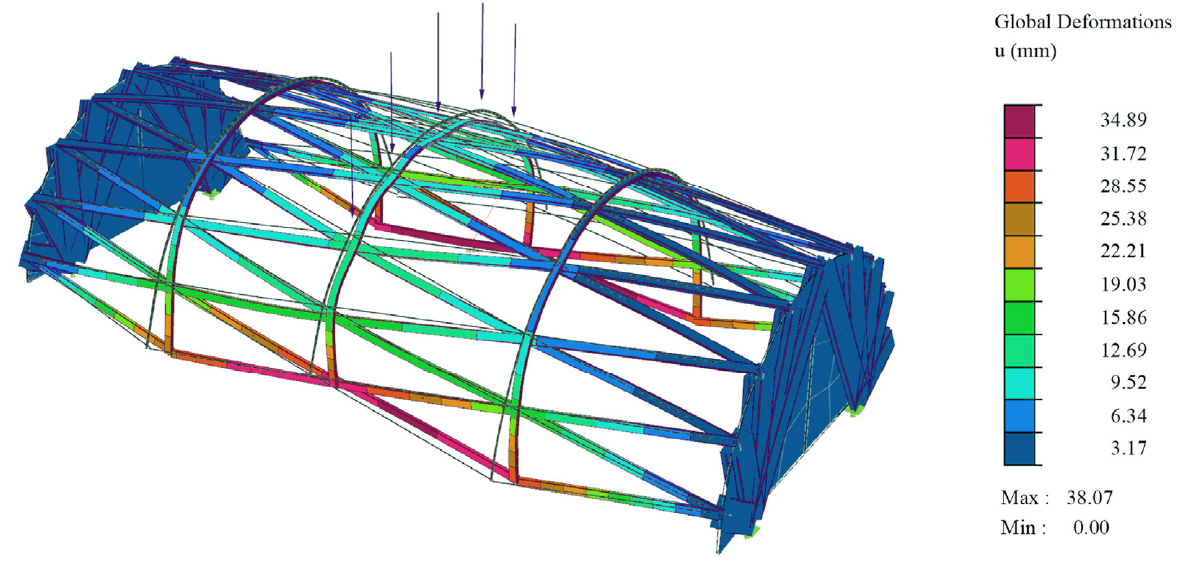
Figure 11. Model C5. Undeformed geometry in lines and deformed geometry in coloured sections for point loads of 1.04 kN (amplification factor = 10).